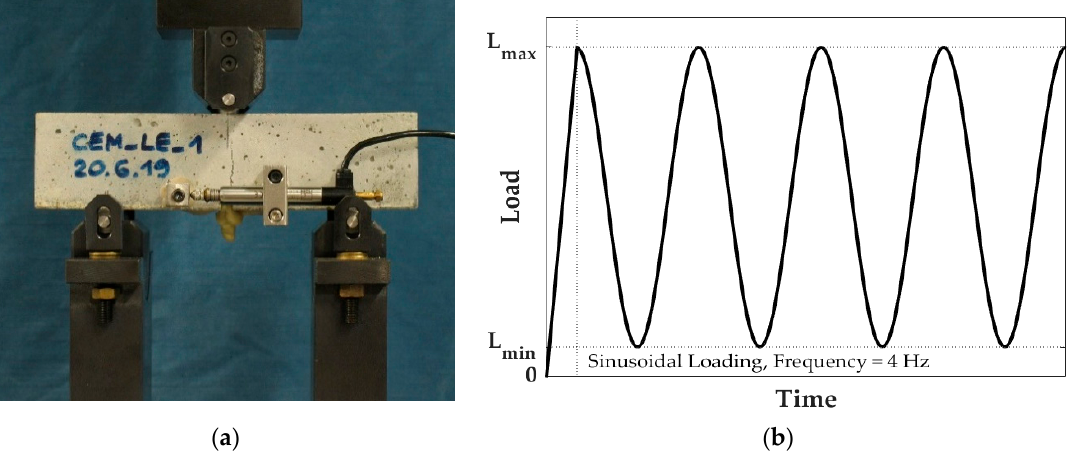
Figure 7. Cyclic reloading procedure: ( a ) experimental setup; ( b ) graphical illustration of the loading procedure for the cyclic